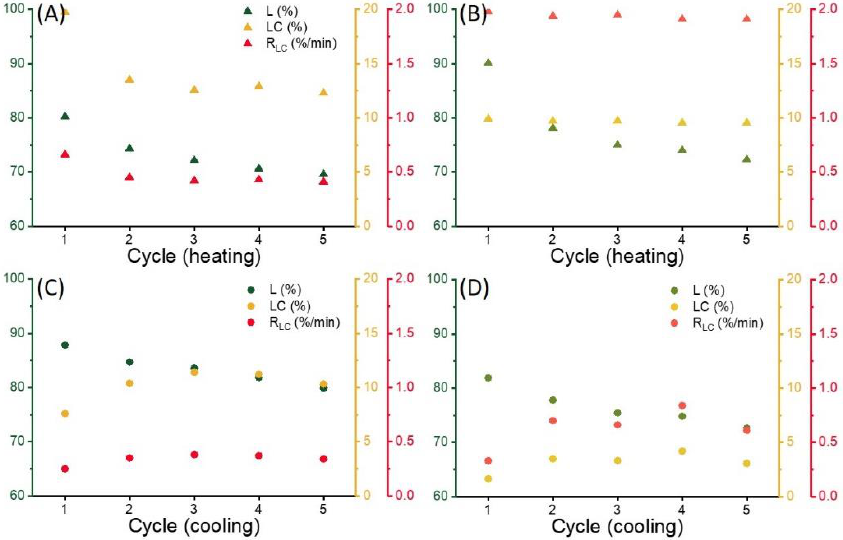
Figure 6. Length (L), final length change (LC) after 30 min, and its linear rate constant (R LC ) of PVA10/(PVA-MA)-g -PNIPAAm while cycling in 30 min intervals between 25 °C and 50 °C in deionized water: ( A ) total response on heating with ( B ) response in the first 10 min, and ( C ) on cooling with ( D ) for first 10